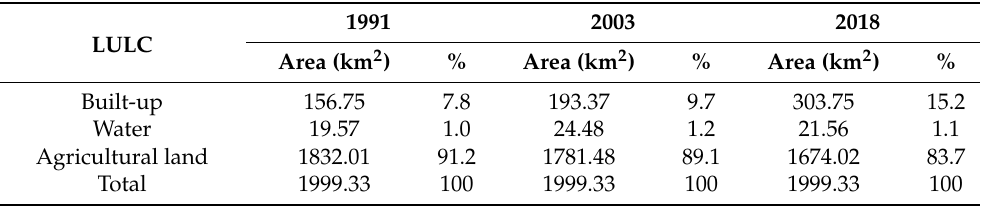
Table 4. Details of LULCC in the Gharbia governorate in 1991, 2003, and